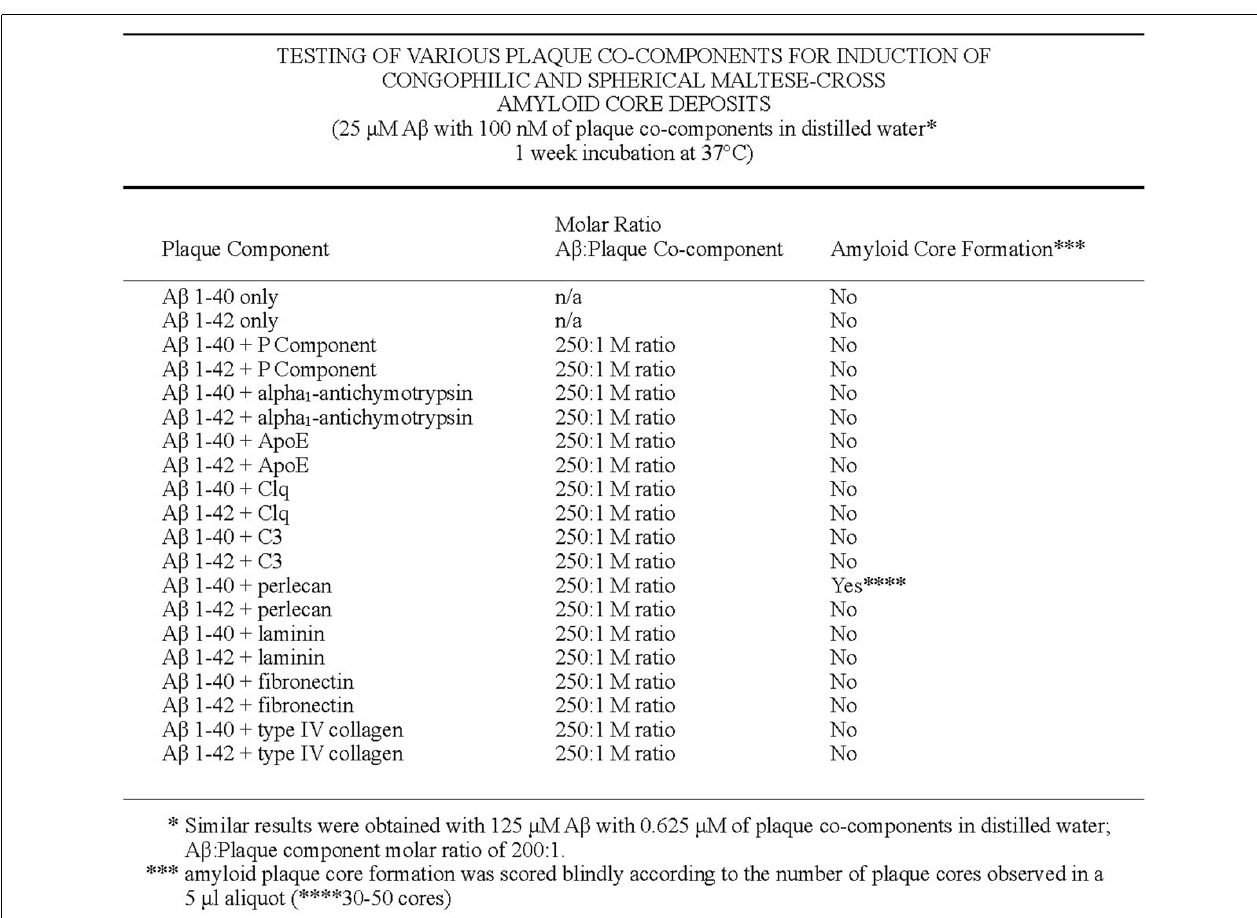
FIGURE 6 | Testing of various plaque core components for induction of congophilic and spherical maltese-cross amyloid core deposits. Different known amyloid plaque co-components including P component, alpha 1 -antichymotrypsin, ApoE, C1q, C3, perlecan (HSPG), laminin, fibronectin, and type IV collagen were tested for their ability to form congophilic spherical maltese-cross amyloid core deposits. Only perlecan (HSPG) were shown to induce congophilic spherical maltese-cross amyloid core deposits identical to those seen in the AD brain (Castillo and Snow,